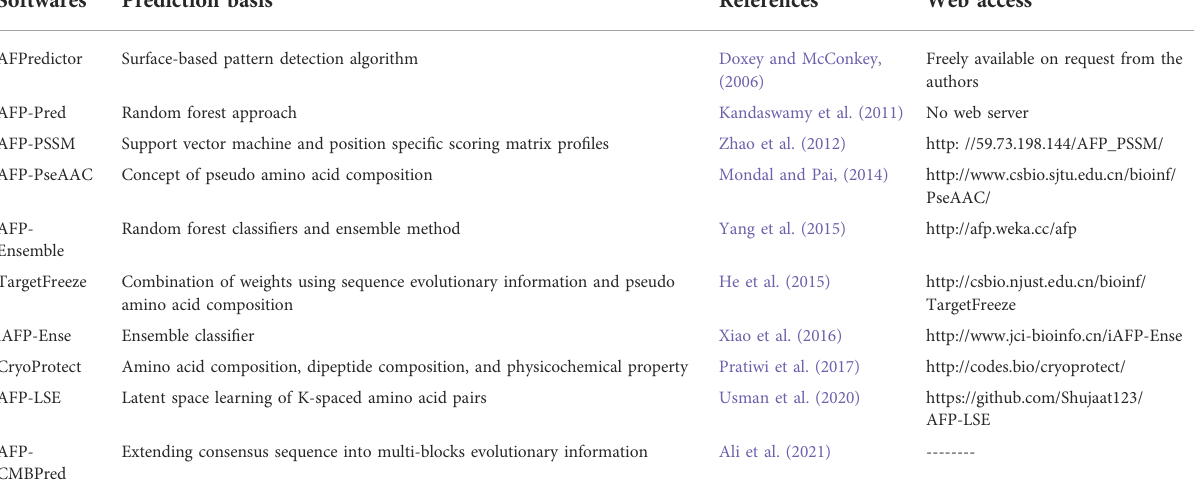
TABLE 2 List of in silico tools used for predicting and analysis of